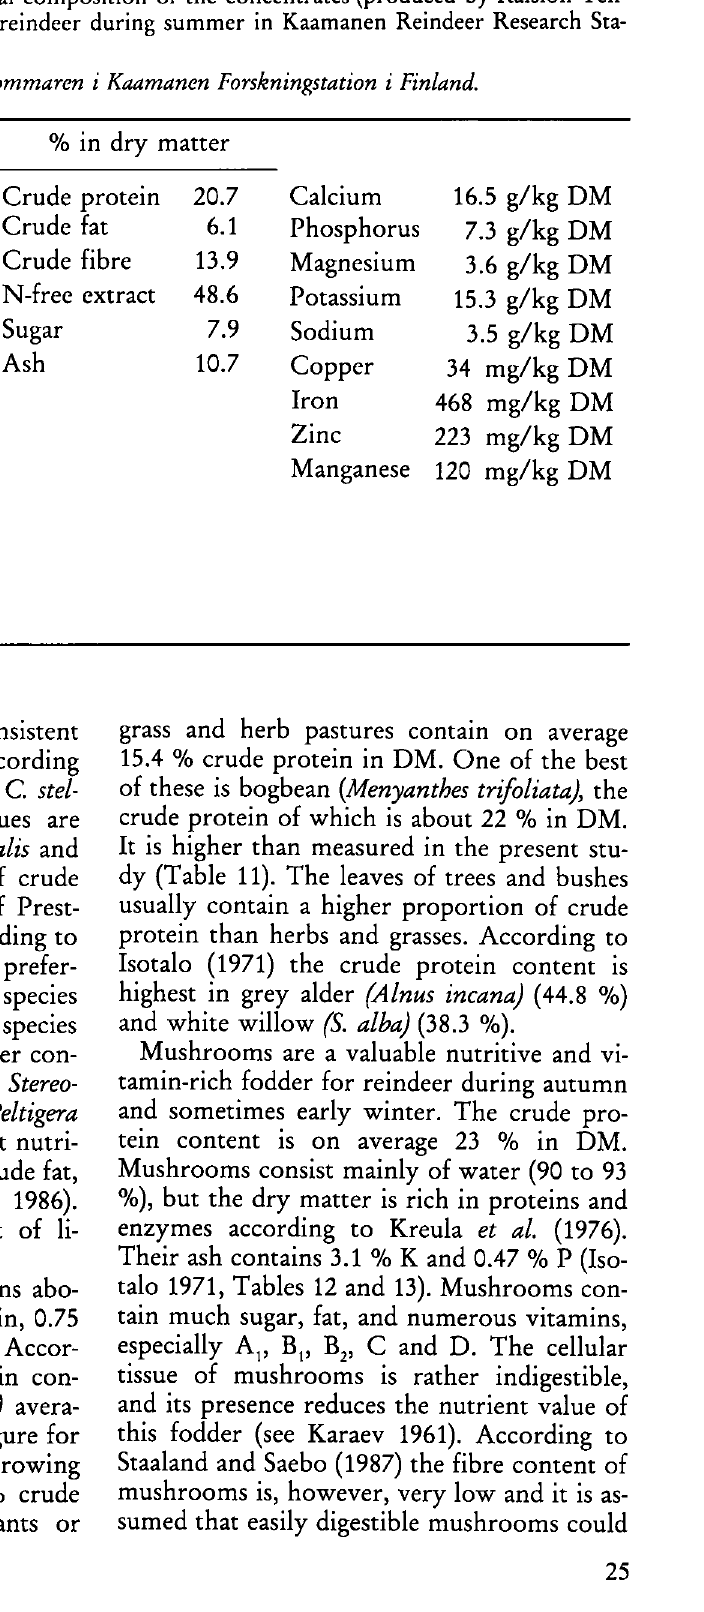
Table 8. The feed component and chemical composition of the concentrates (produced by Raision Teh- taat Oy) used for the feeding of reindeer during summer in Kaamanen Reindeer Research Sta tion in